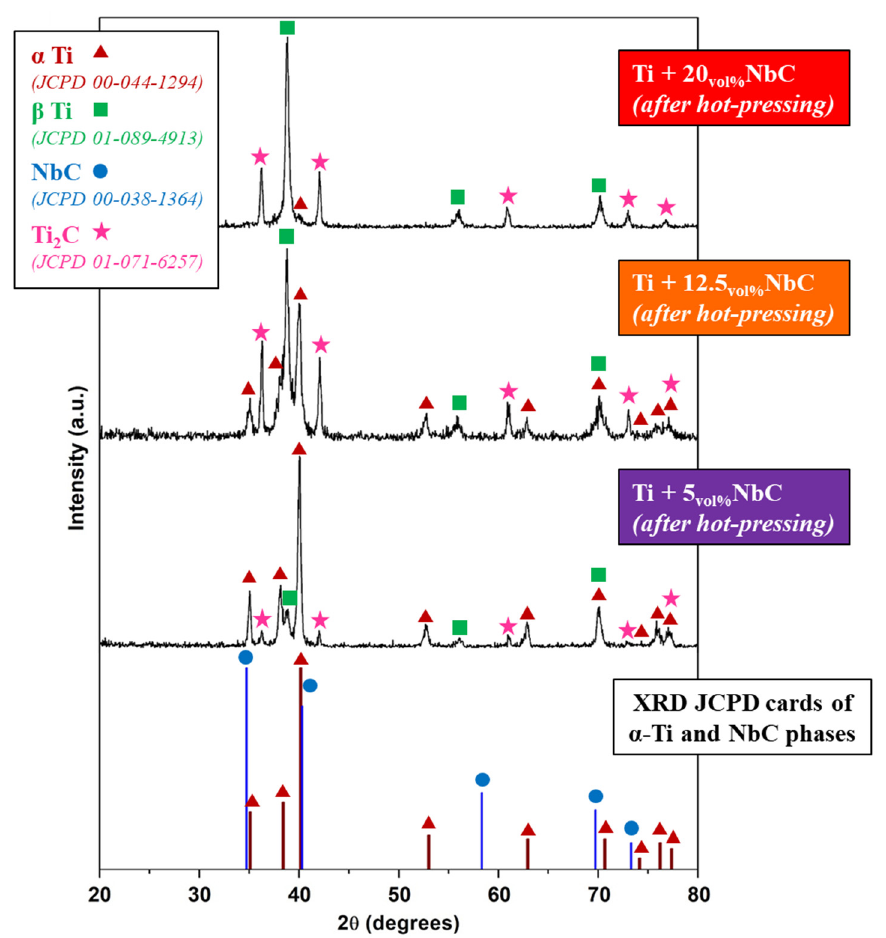
Figure 1. XRD patterns of the Ti/NbC system.